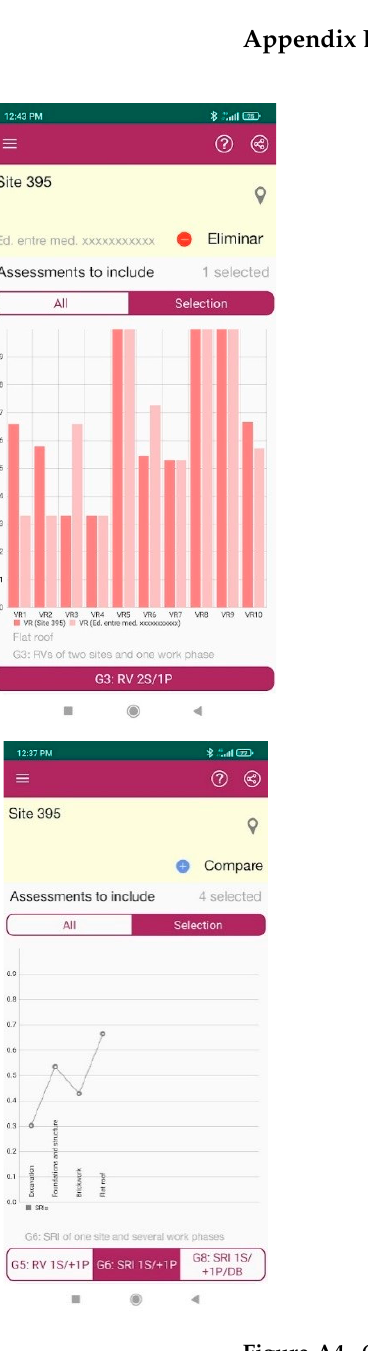
Figure A3. Different screens showing site assessment, general menu, and specific questions with possible answers. Source: App screenshots.